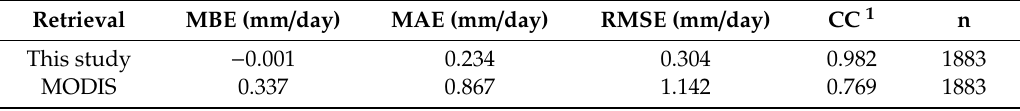
Table 8. Comparison of the accuracy statistics of the ML model and Moderate Resolution Imaging and Spectroradiometer (MODIS) product using 8-day composite data for croplands in South Korea for the 2013–2019